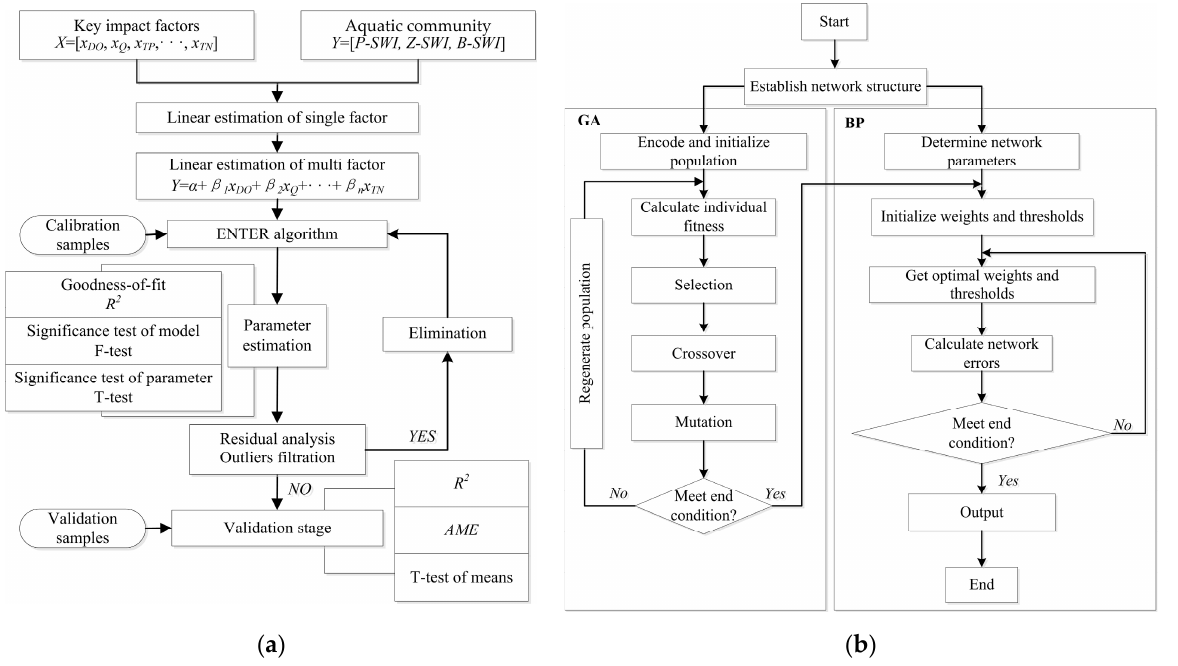
Figure 2. Flow diagram indicating the model conceptualization and building process of the MLE and GA-BP models. ( a ) MLE model, ( b ) GA-BP model.